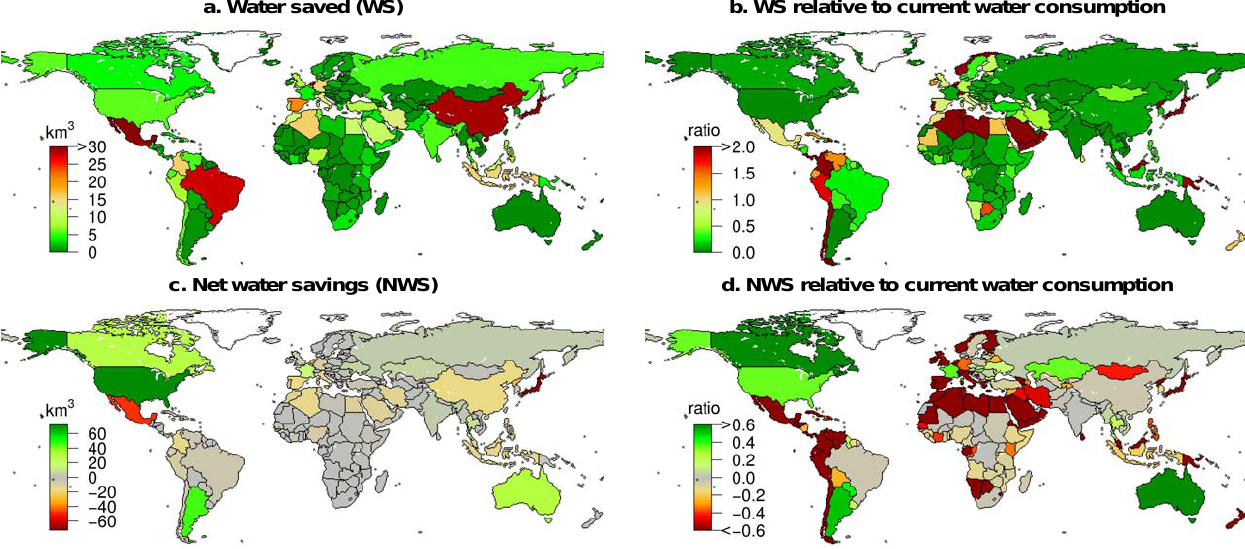
Fig. 6. (a) Green plus blue water volumes (WS in km 3 ) that would be required in a country’s own territory for the production of imports Fig. 6 . (i.e. water saved through imports), (b) WS relative to current water consumption E (values > 1 indicate that own production of imports would need an amount of water more than double the present amount), (c) net water savings NWS, i.e. WR–WS, and (d) NWS relative to E . (Negative values in (c) and (d) indicate the need for consuming more water for crop production in case of no international trade).